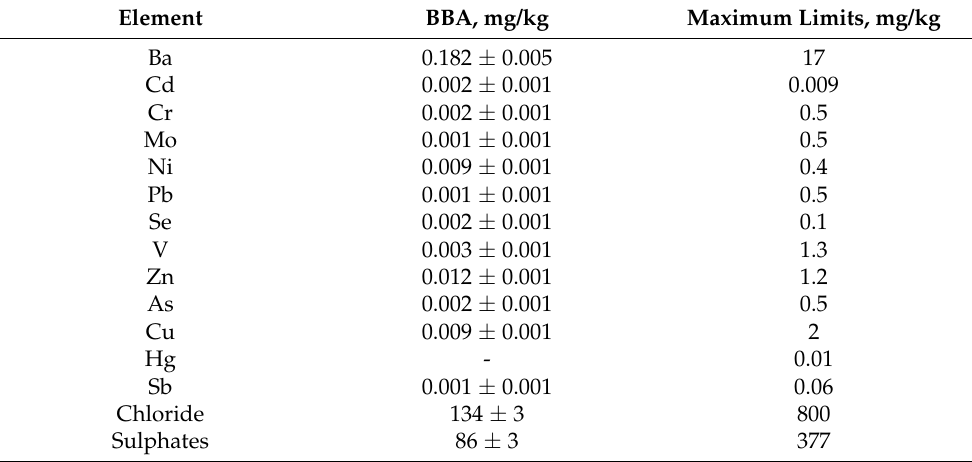
Table 4. Concentration of chemical elements in biomass bottom ash leachate compared with regulatory limits.